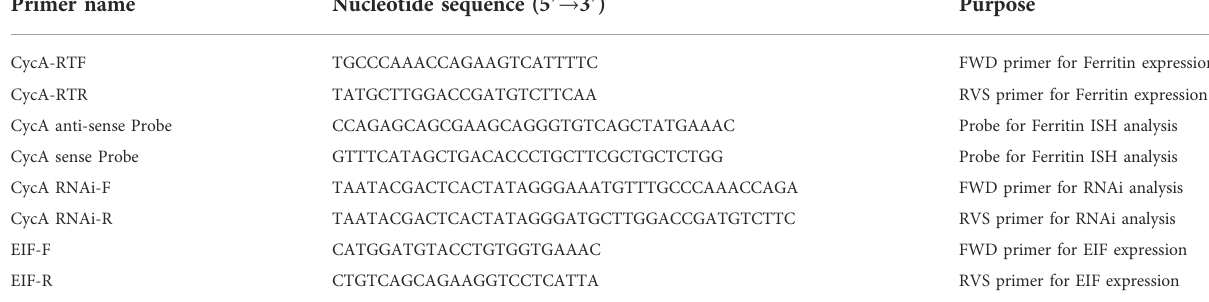
TABLE 1 universal and speci fi c primers used in this